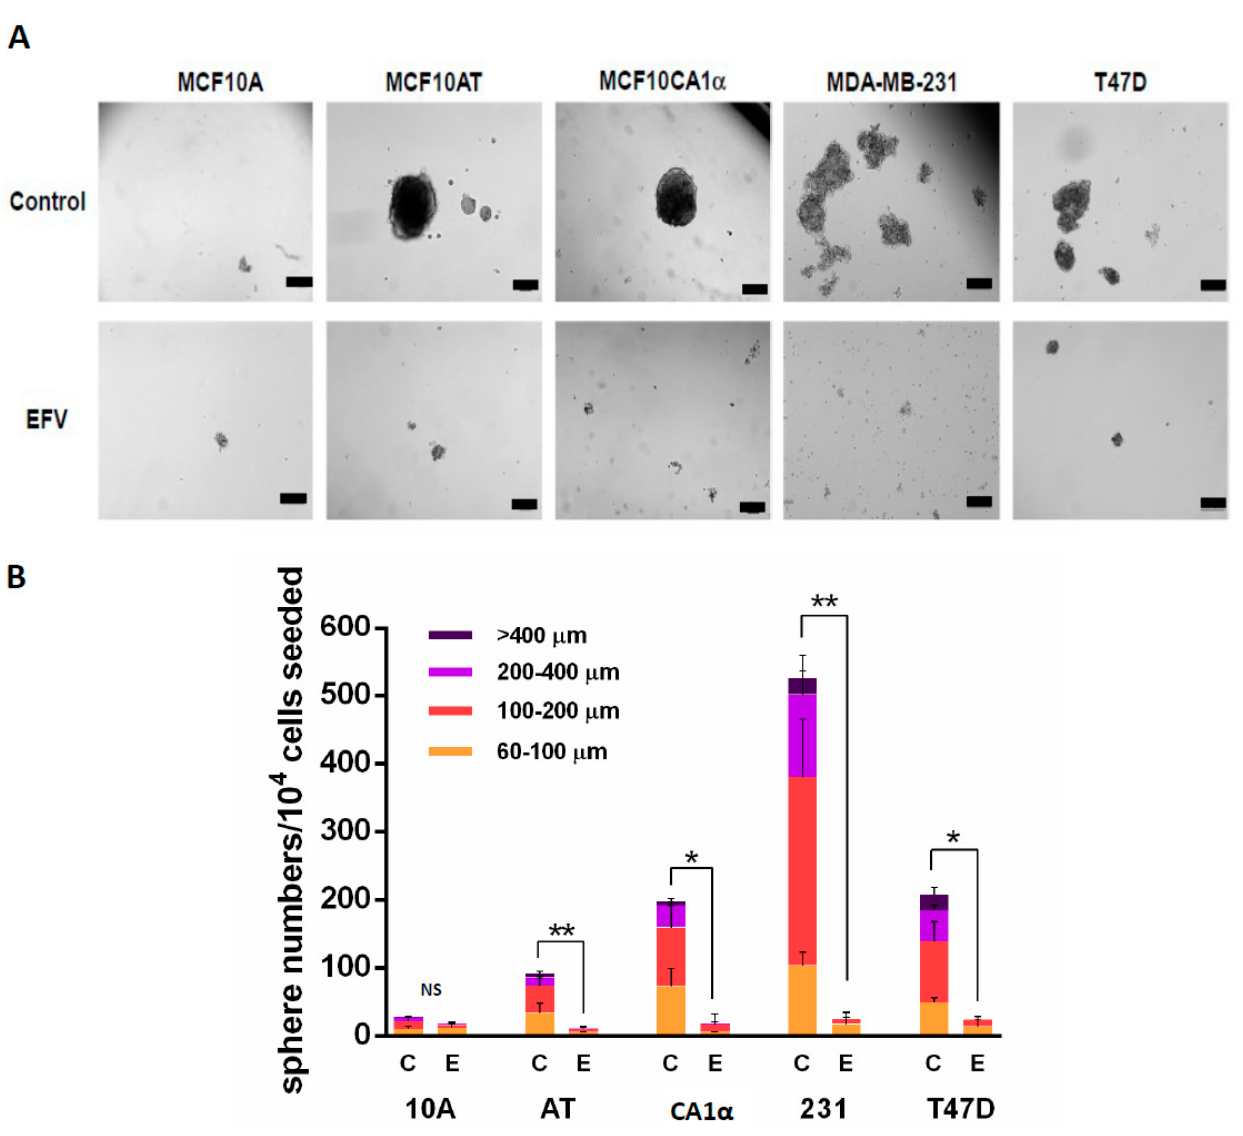
Figure 5. Efavirenz reduces tumorsphere formation in breast cancer cell lines. ( A ) Tumorsphere formation of breast cancer MCF10AT, MCF10CA1 α , MDA-MB-231 and T47D cells were disrupted by Efavirenz treatment based on their EC50 values described in our previous study [22]. ( B ) Numbers of tumorspheres formed in untreated and Efavirenz-treated breast cancer cells. Any clump smaller than 60 µ m is not considered as a tumorsphere. Two-tailed, paired Student’s t -test was conducted for statistical analysis, and the total cell numbers are compared between untreated and Efavirenz-treated conditions. (paired Student’s t -test, * p < 0.05; ** p <0.01). Error bars: ± SD, n = 3. C: untreated control cells, E: Efavirenz-treated cells. Scale bar: 200 µm.